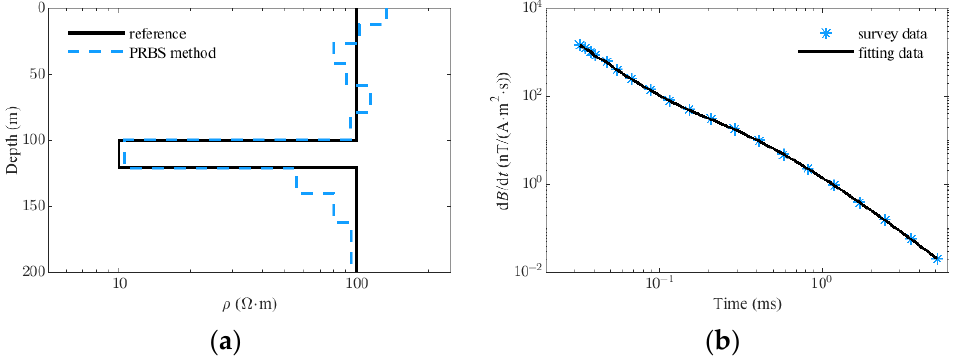
Figure 13. The inverted model based on the survey data of the PRBS method. ( a ) Reference earth